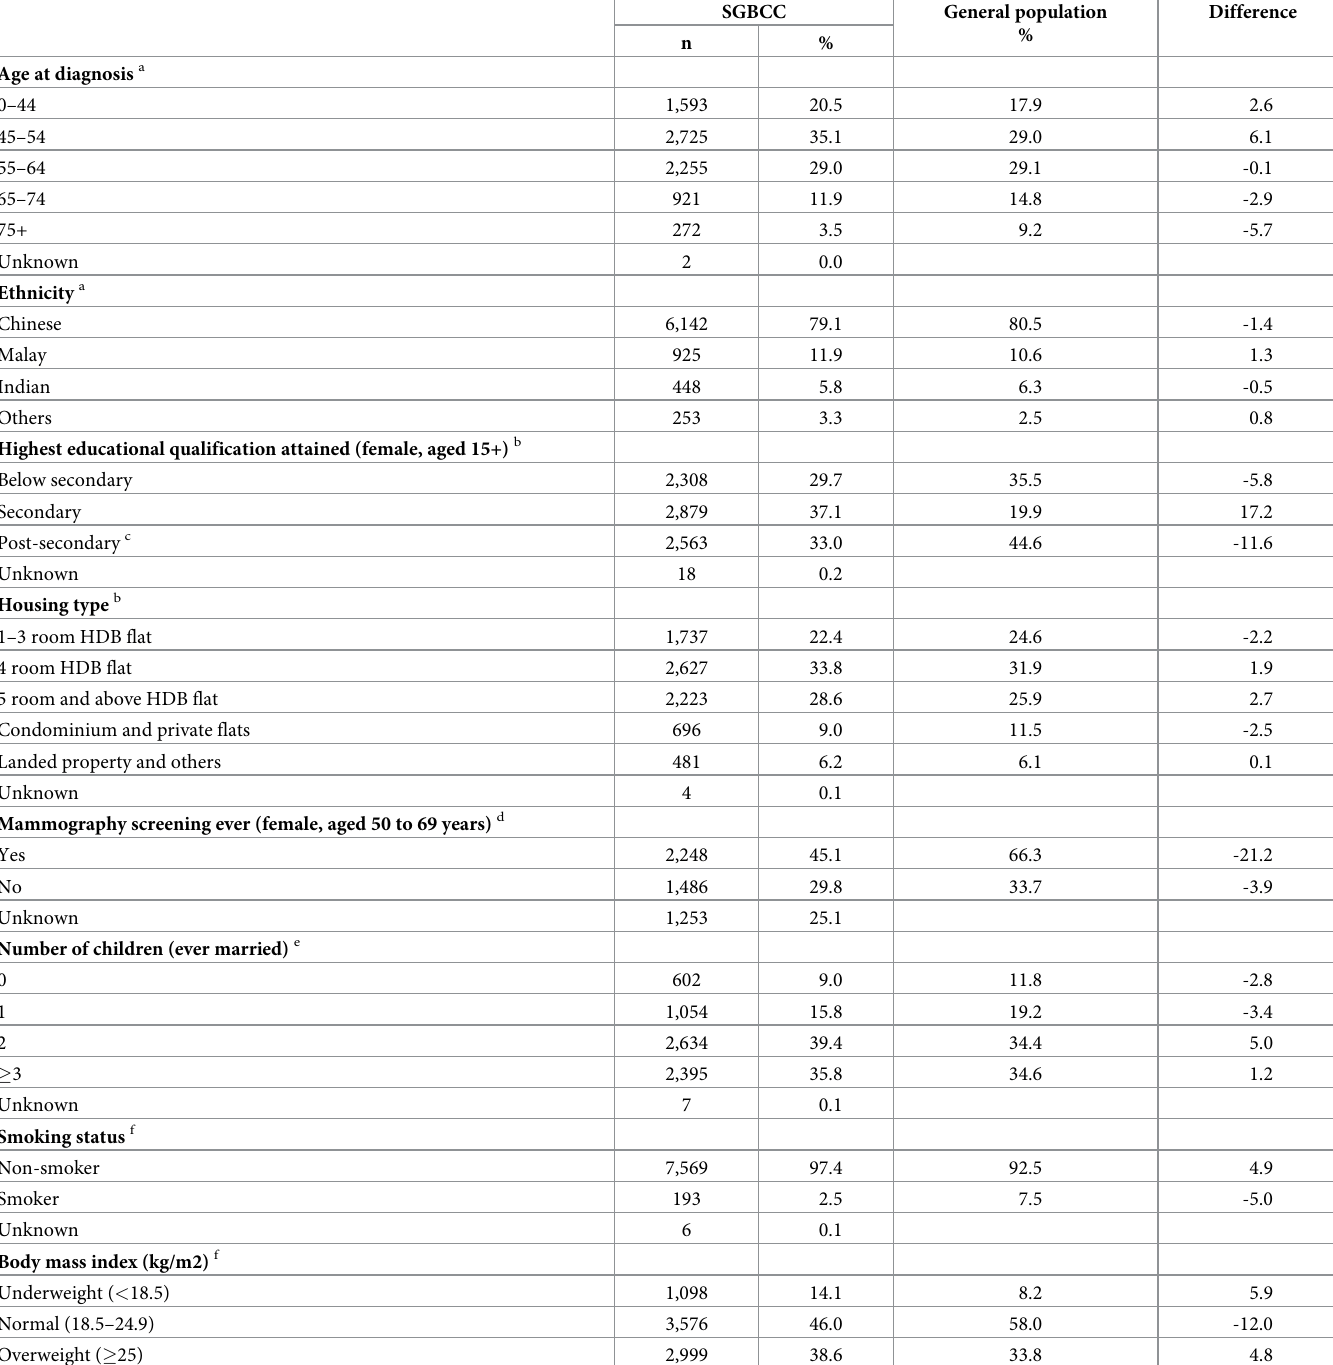
Table 1. Body mass index, lifestyle and demographic profile of SGBCC participants, recruited between April 2010 and Dec 2016, compared with the general popula- tion in